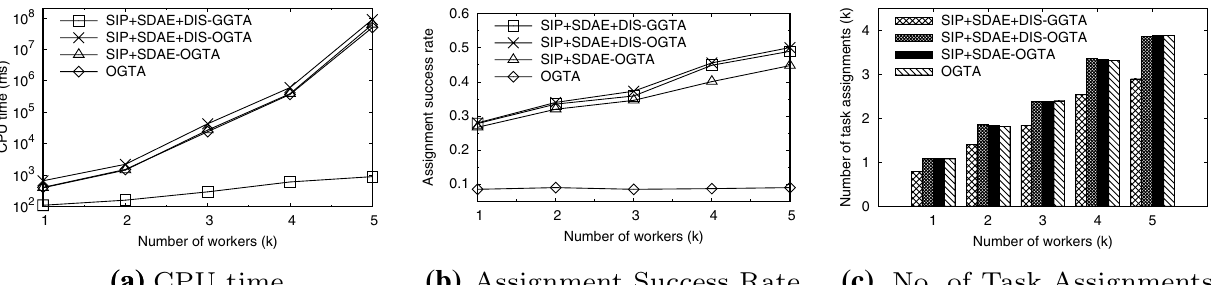
Fig. 14 Performance of group task assignment: effect of | W